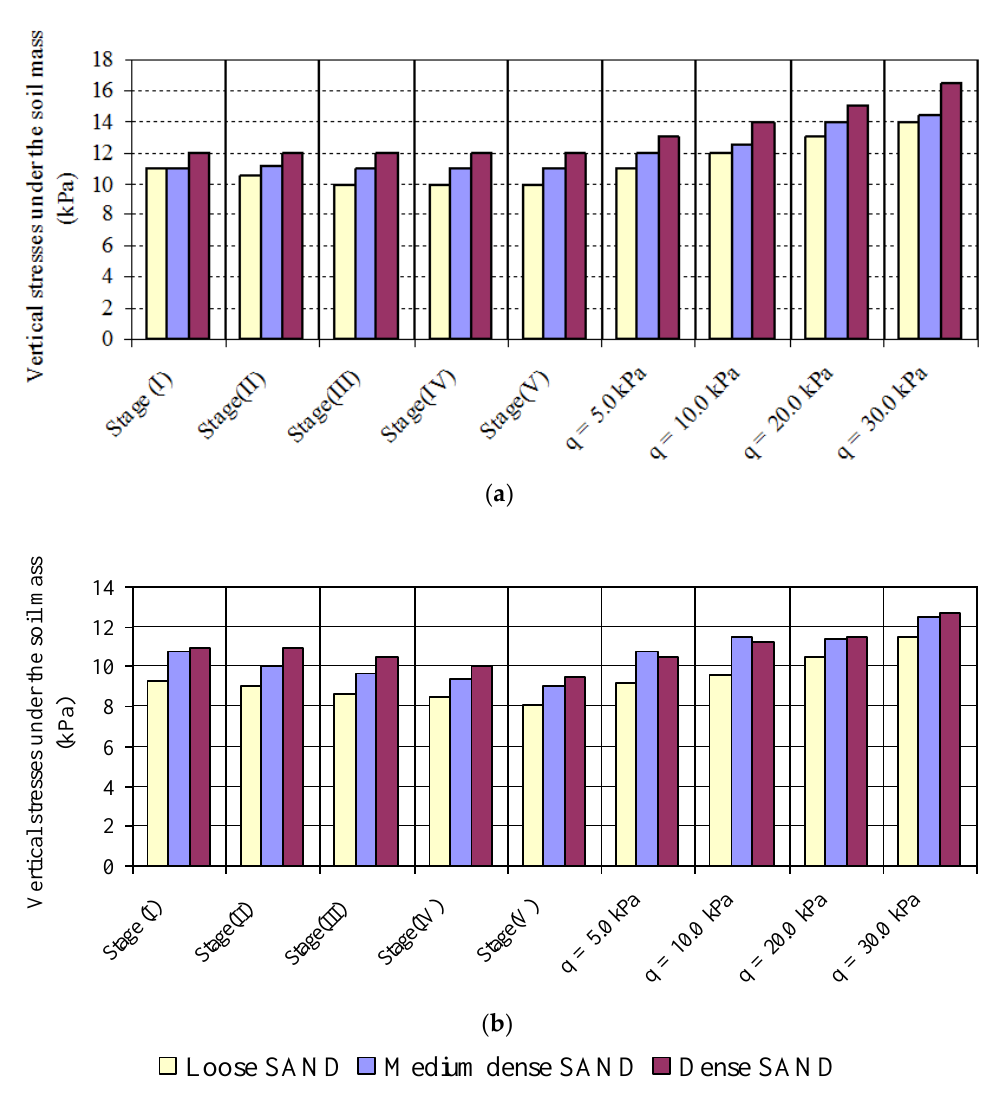
Figure 35. Effect of soil density on the vertical stresses under the nailed soil mass at mid-point; ( a ) numerical model; ( b ) laboratory model.